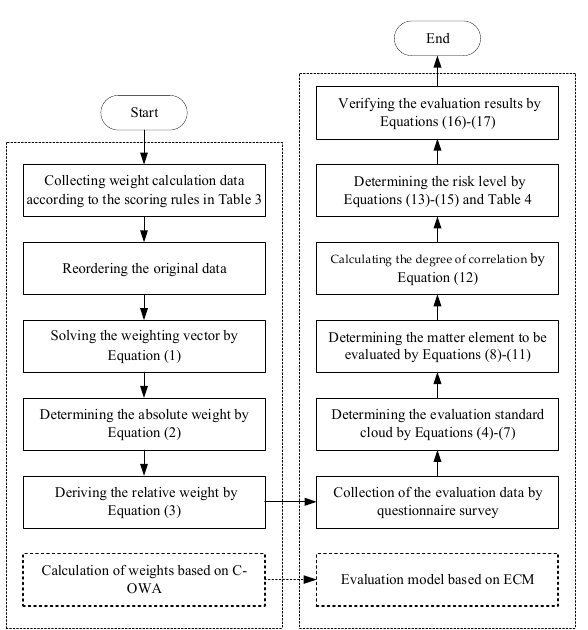
Figure 3. Flowchart of the proposed mode.